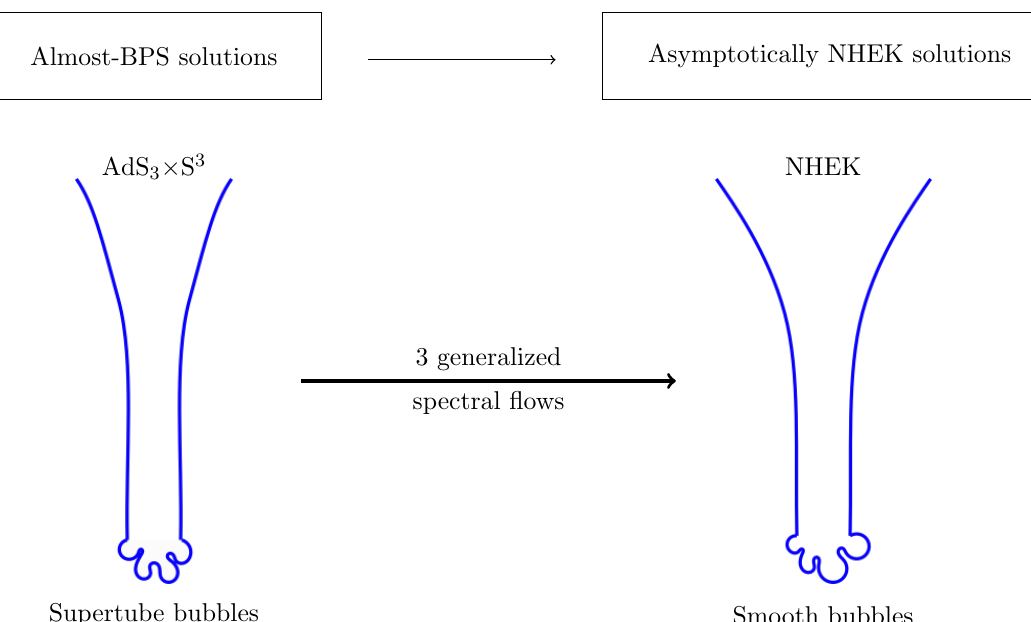
Figure 1 . Schematic description of the construction of a family of smooth asymptotically NHEK solutions from the family of almost-BPS